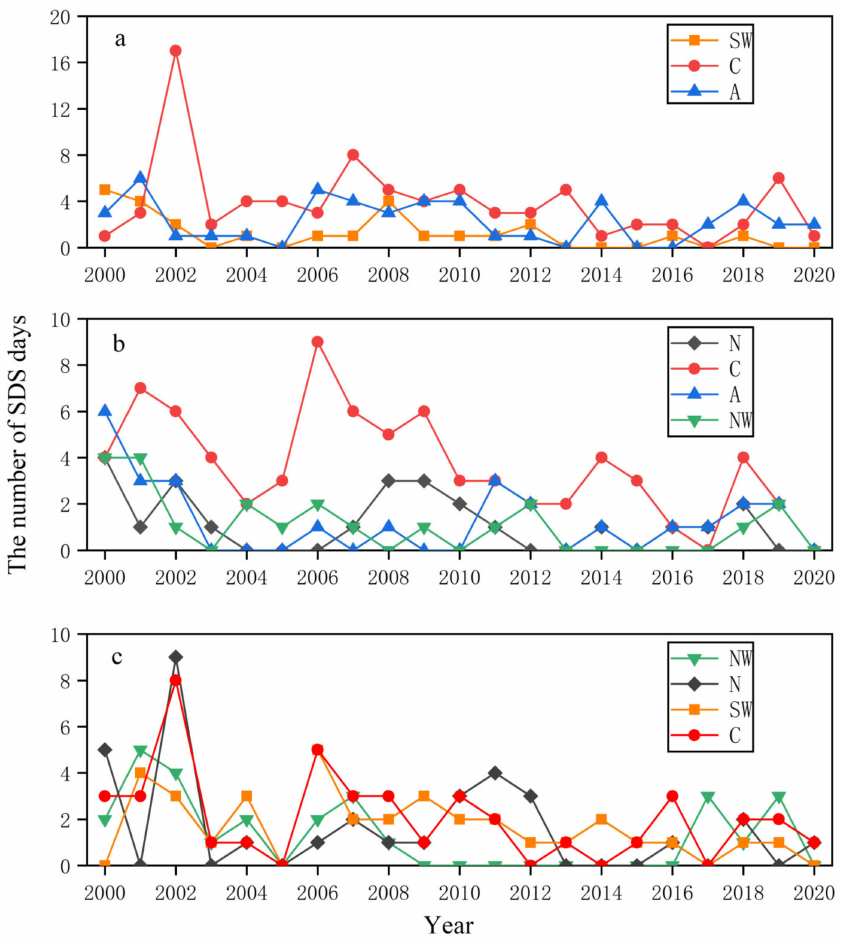
Figure 4. Annual variation of dominant circulation pattern in ( a ) the southern Xinjiang basin, ( b ) western Inner Mongolia and southern Mongolia, and ( c ) the center of Inner Mongolia in spring from 2000 to